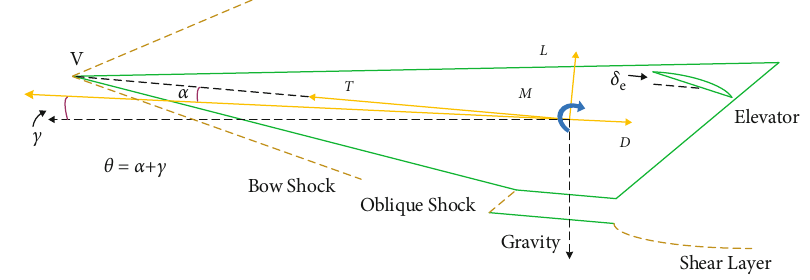
Figure 1: Geometry and force map of HFV